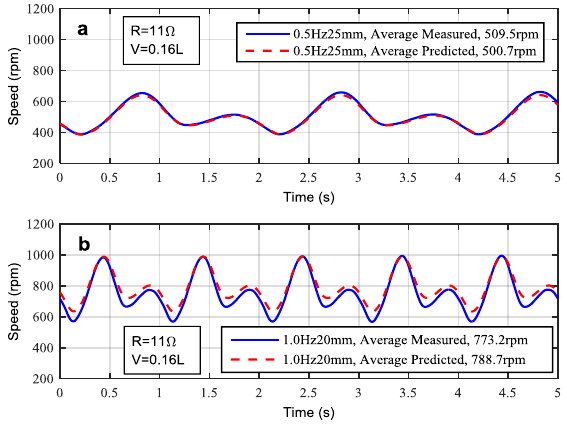
Figure 12. Predicted and measured motor speed at ( a ) 0.5 Hz frequency and 25 mm amplitude; and ( b ) 1.0 Hz frequency and 20 mm amplitude.